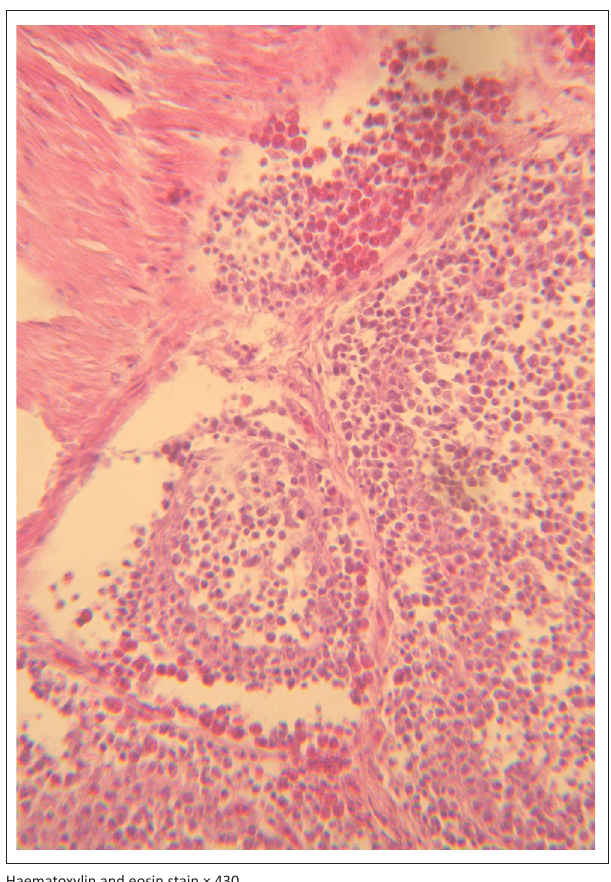
FIGURE 5: Acute inflammation accompanied by necrosis and heterophil infiltration in the bursa of Fabricius, 6 days post-inoculation. TABLE 2: Virus detection in various tissues of chicken after inoculation with 793/B serotype of infectious bronchitis virus. Days